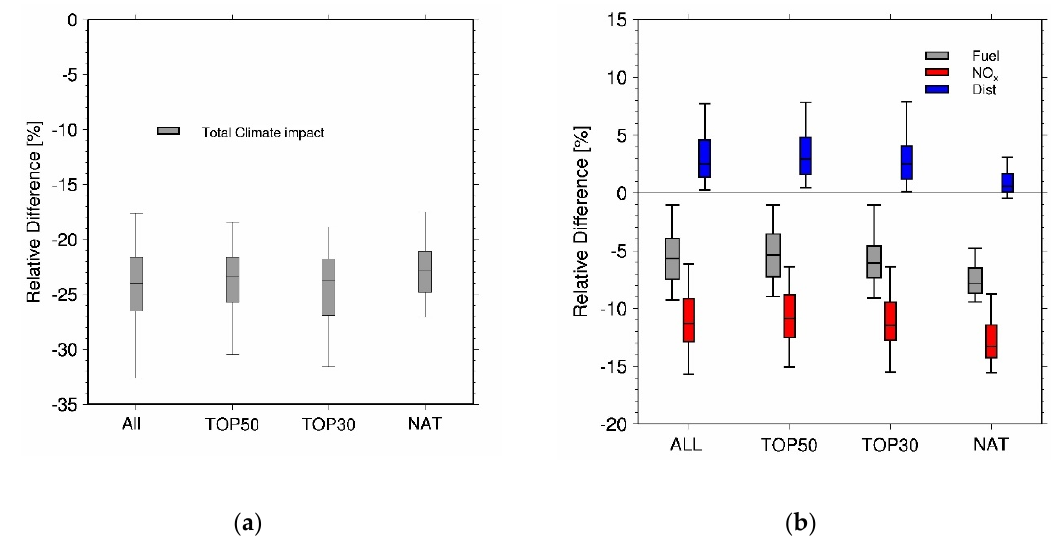
Figure 4. ( a ) Relative change in total climate impact for the total formation for the T50 scenario in relation to the reference case, where all aircraft fly without formation. ( b ) Same as ( a ) but for fuel consumption, NO x emissions and flown distances. The bars indicate the 25% and 50% percentile and the whiskers indicate the 95% confidence interval of the different formations in one data set.